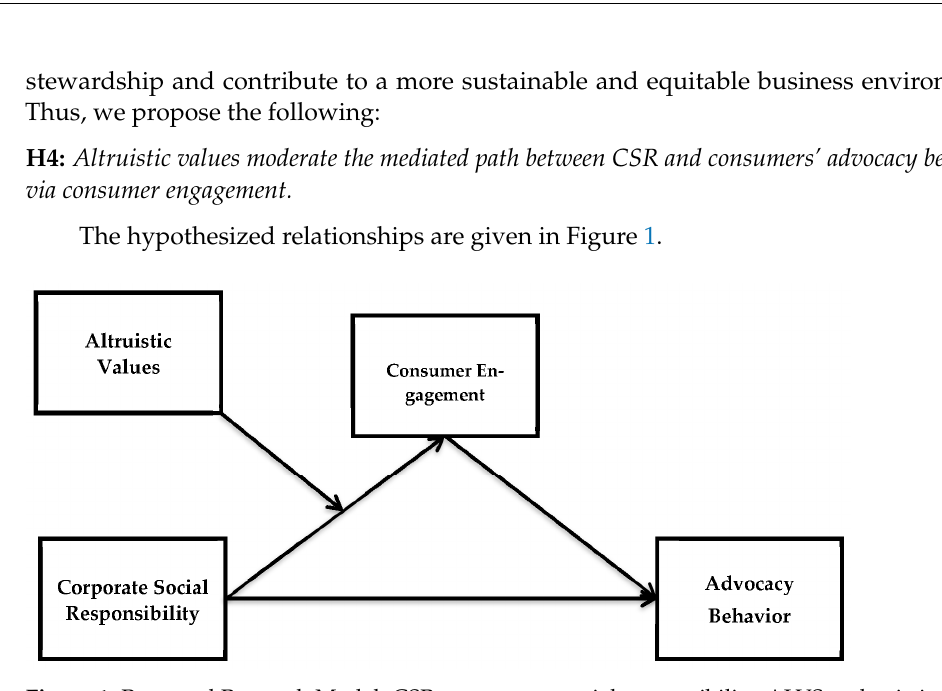
Figure 1. Proposed Research Model. CSR = corporate social responsibility, ALVS = altruistic val- ues, CENG = consumer engagement, BADB = brand advocacy